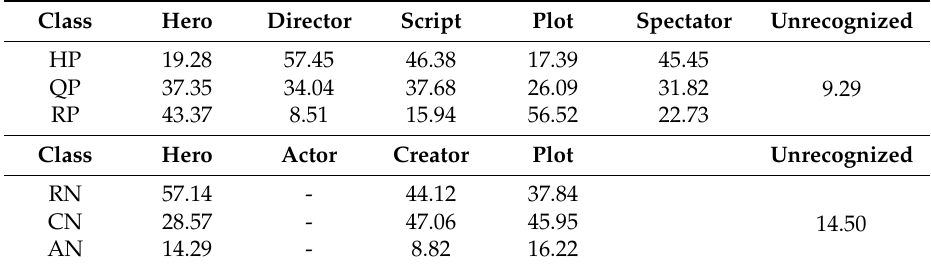
Figure 3. The difference between the average values of quality evaluation of the one-level and simple sentiment classifying. Source: own research results. Table 19. Contextual Framework of the 1st level of Film Reviews Corpora (% to the total number of paragraphs).